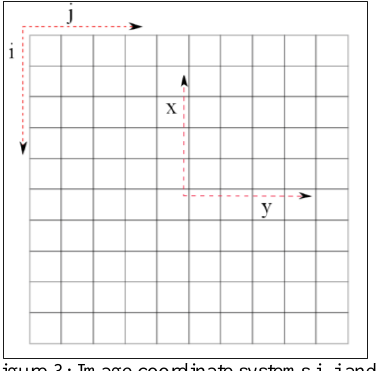
Figure 3: Image coordinate systems i, j and x,y